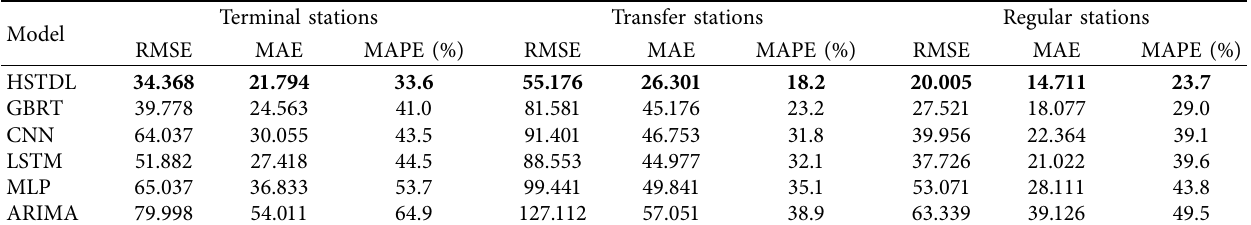
Table 6: The comparison of different models (outbound passenger